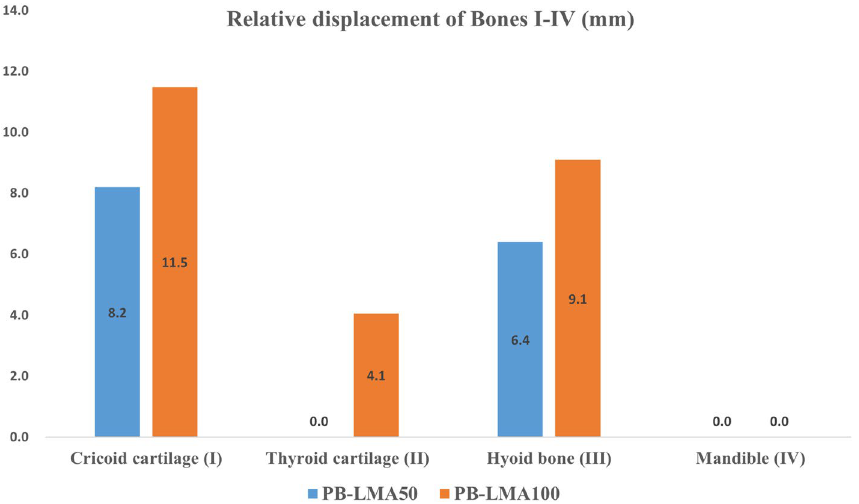
Figure 6. Displacement of pharyngeal Bones I–IV caused by LMA inflation, with respect to the spine